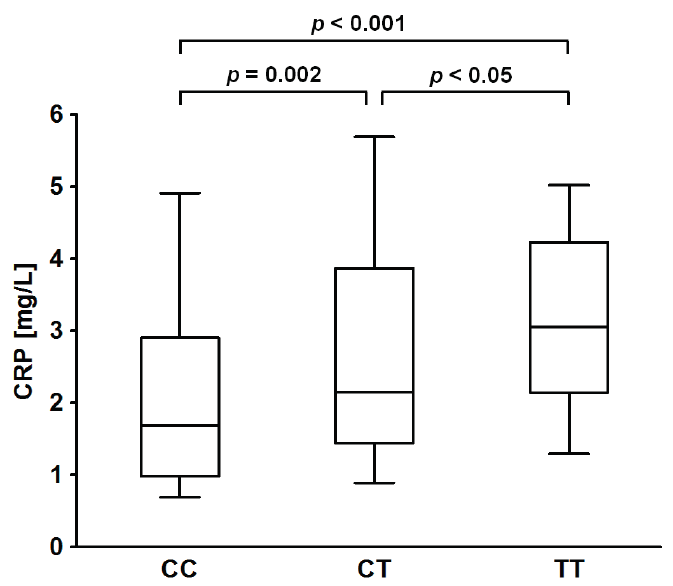
Figure 1. Boxplot describing the relationship of plasma C-reactive protein ( CRP ) gene rs1205 C>T polymorphism with the CRP levels; boxes range from the 25th to the 75th percentile with a horizontal black line at the median and vertical lines extending to the 10th and 90th percentiles. Crude p -values calculated by Mann-Whitney U test are